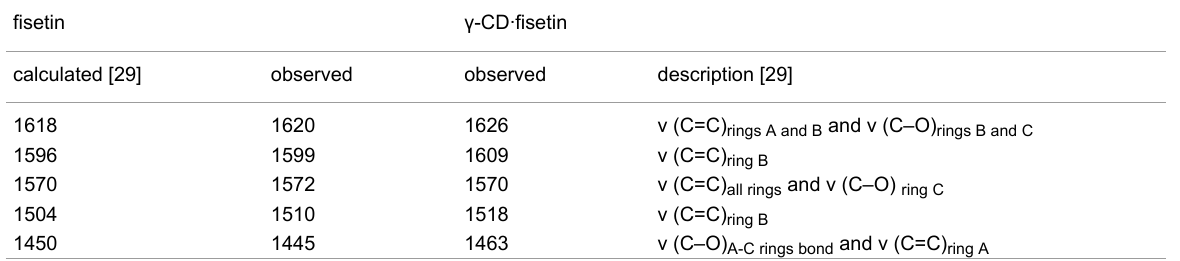
a Refer to Scheme 1a for the numbering of carbon atoms and labeling of the rings of fisetin. b Values given in cm − 1 .